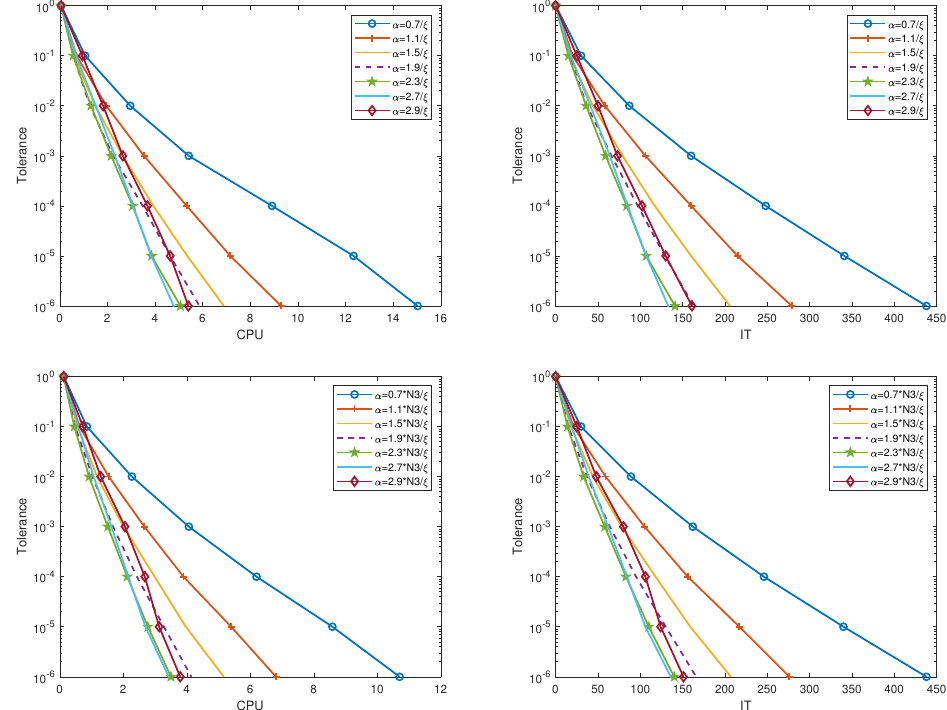
Figure 1. CPU and IT of the TRAK and TRAK F algorithms with the number of partitions s = 10 and different stepsizes α for different tolerances. Upper : TRAK. Lower : TRAK F